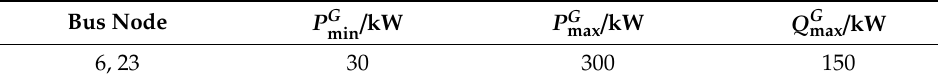
Table 5. Parameters for cost.